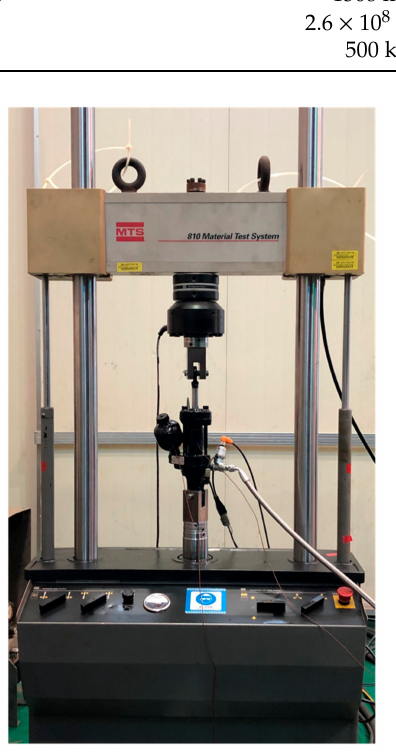
Figure 6. Installation of suspension characteristic test